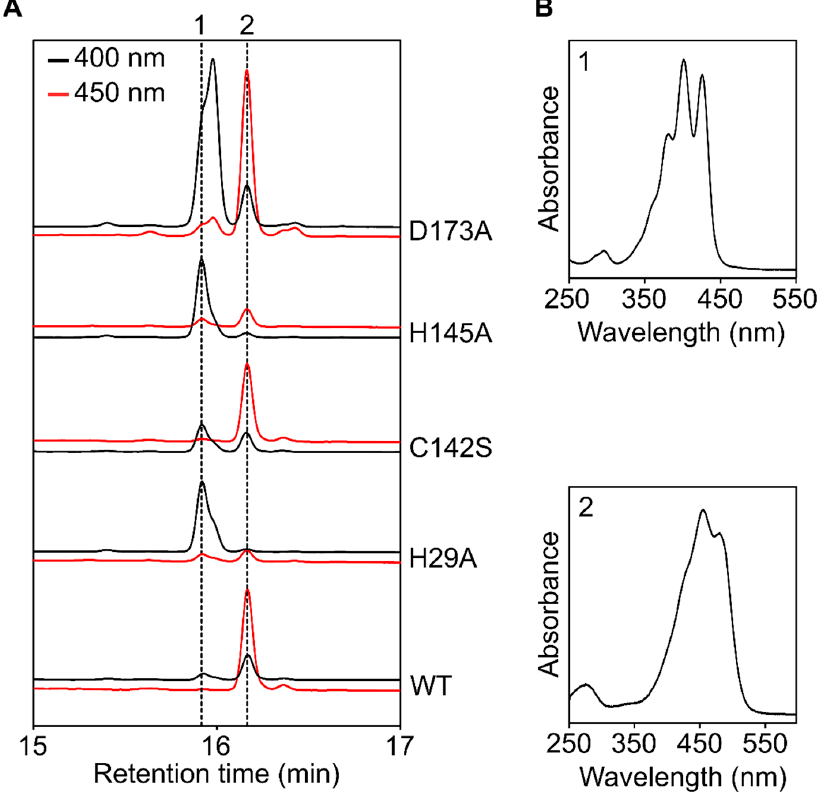
Figure 5. Complementation of the Δ slr1599 mutant enables the identification of functionally important residues. ( A ) Analysis of the activity of the indicated Slr1599 variants produced in the Δ slr1599 background. Strains were grown under LAHG conditions and carotenoids were extracted and separated by RP-HPLC, and detected by absorbance at 400- and 450 nm. Dotted lines and numbers correspond to the spectra in panel ( B ). ( B ) Absorbance spectra of the carotenoid peaks in panel ( A ). Peak 1 = 9,15,9’-tri- cis - ζ -carotene and peak 2 = β -carotene.